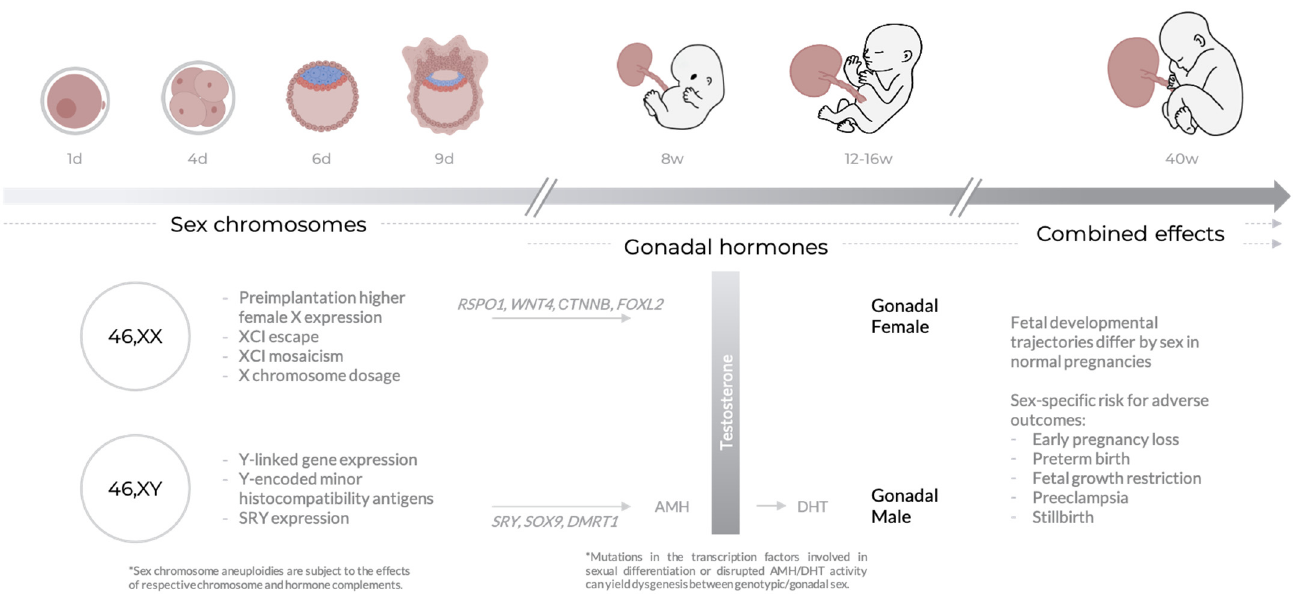
Figure 1. Typical sex differences across gestational age. Throughout pregnancy, sex differences may arise as a consequence of both sex chromosome and sex hormone (testosterone) biology. The combined effects of sex chromosomes and hormones on placental function may contribute to sex differences in healthy development and risk for adverse pregnancy outcomes. Section 3 contains more detailed descriptions of the processes mentioned in this figure, in particular those relating to the X chromosome.